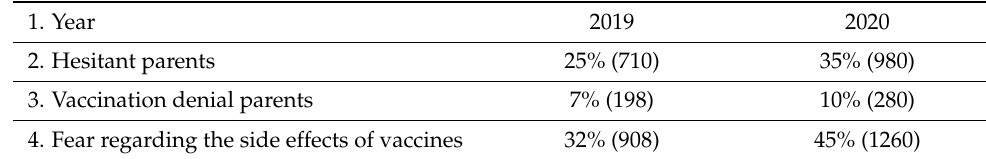
Table 6. Parental attitudes regarding